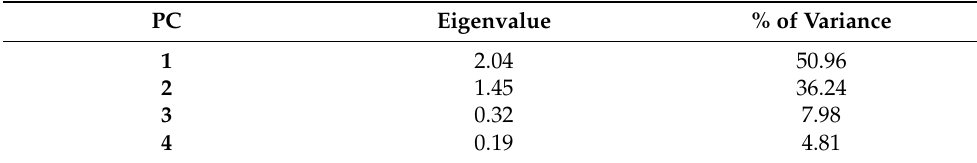
Table 3. Explained variance using principal component analysis.